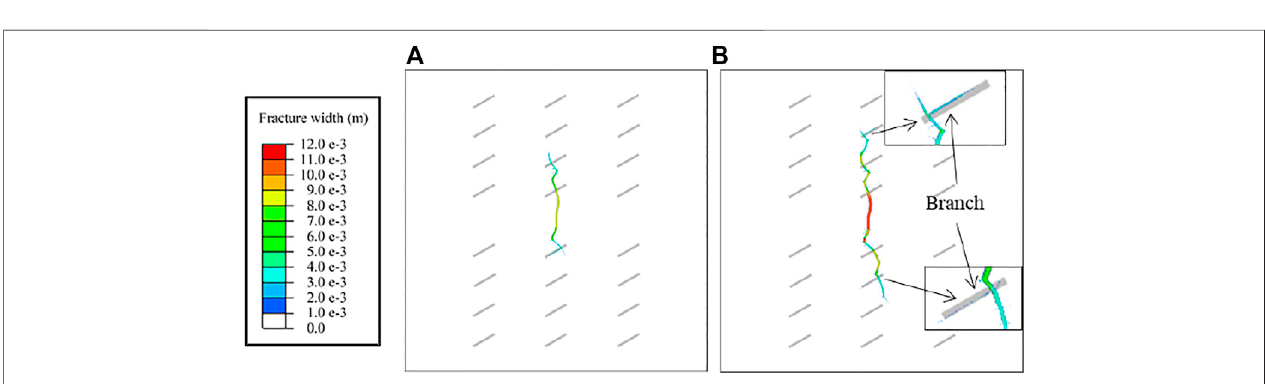
FIGURE 10 | Morphology of hydraulic fracture network under different injection rates: (A) 0 . 005 m 3 / s , case 9; (B) 0 . 01 m 3 / s , case 2.